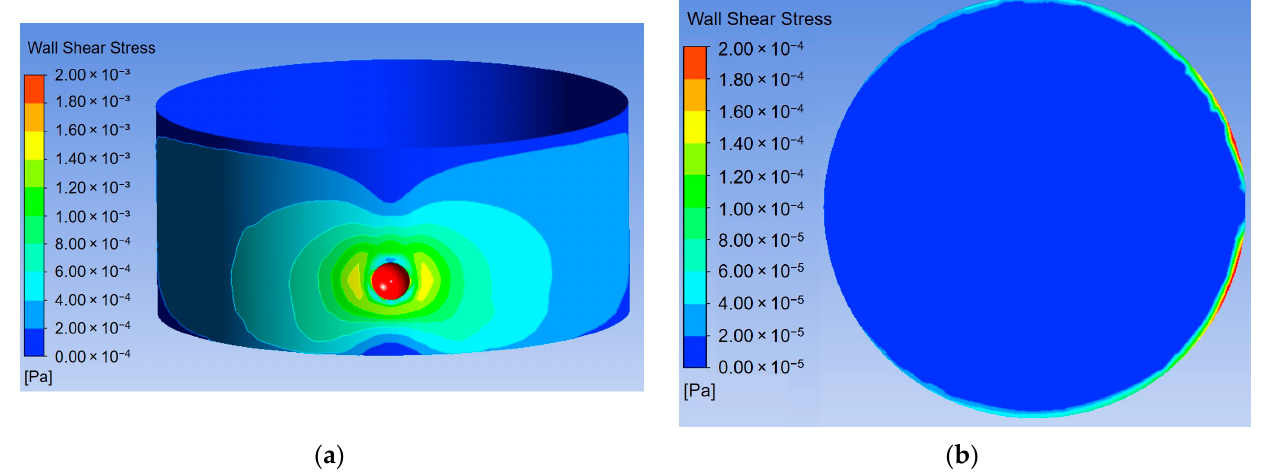
Figure 4. Shear-stress distributions on ( a ): the inner-sidewall and ( b ): the bottom of the hearth.